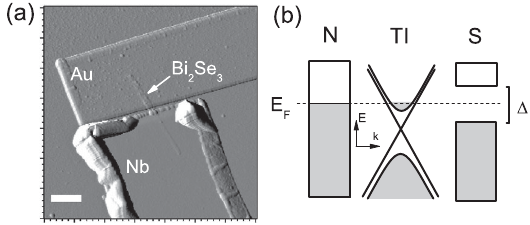
FIG. 1. (a) AFM image of N-TI-S device, where N stands for the normal metal lead (Au) and S is the superconducting lead (Nb). The Bi 2 Se 3 segment originally consisted of two adjacent nanoribbons that are each 9 nm thick, but subsequent AFM imaging after measurements revealed only one nanoribbon remaining under the niobium lead [30]. Separation between N and S leads is L ¼ 230 nm, as determined from SEM. White scale bar is 1 μ m. (b) Energy diagram for the three materials in the device. The TI (whose dispersion relation is depicted with both gapless helical surface states and gapped trivial states) is sandwiched between a compressible normal metal and a super- conductor with an energy gap Δ